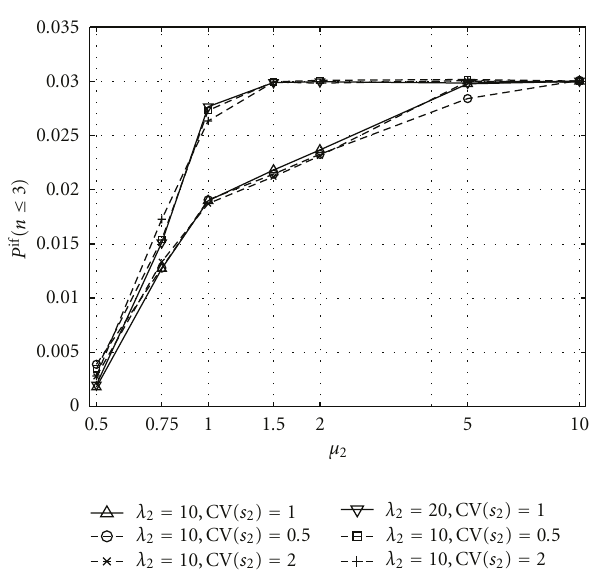
Figure 11: Interference ( P if ( n ≤ 3)) with μ 2 and CV[ s 2 ] in